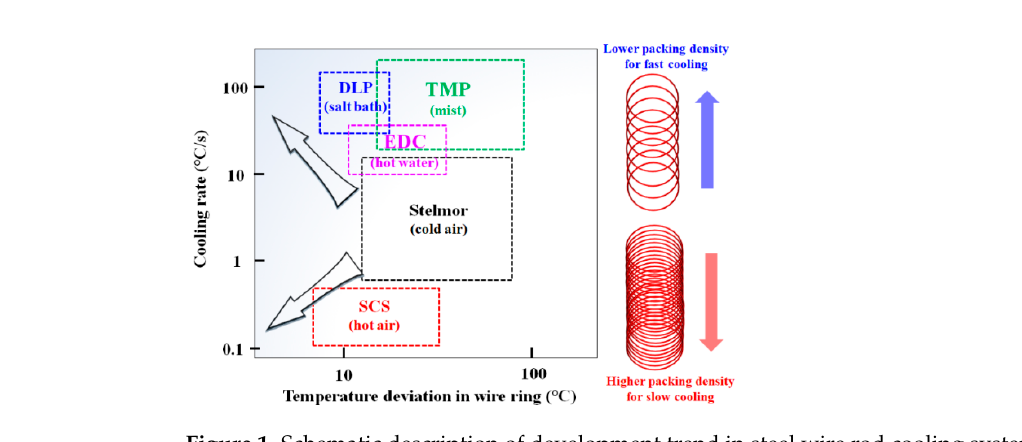
Figure 2. Configuration of wire ring on a Stelmor cooling system and microstructure of wire rod with local decarburization at central region of wire ring.